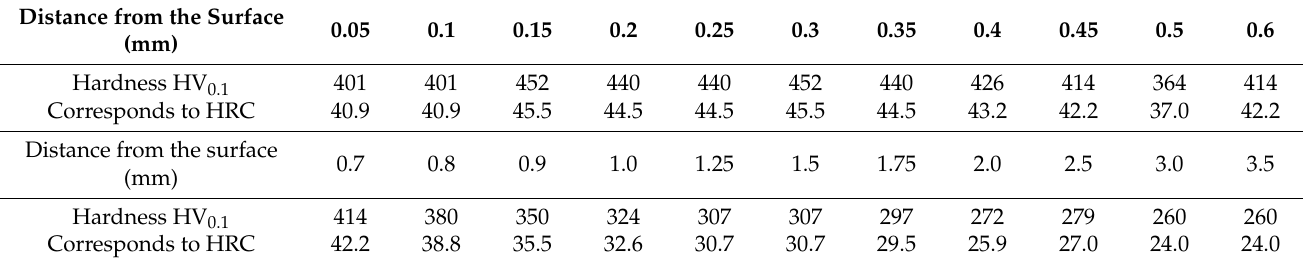
Figure 9. Microhardness measurements’ directions on the inactive tooth flanks: tooth hard-faced with the DUR 600-IG FM ( a ) and tooth hard-faced with the EVB2CrMo FM ( b ). Table 7. Microhardness of the inactive tooth flank of the tooth hard-faced with the DUR 600-IG FM—direction I-I. Distance from the Surface (mm) Hardness HV 0.1